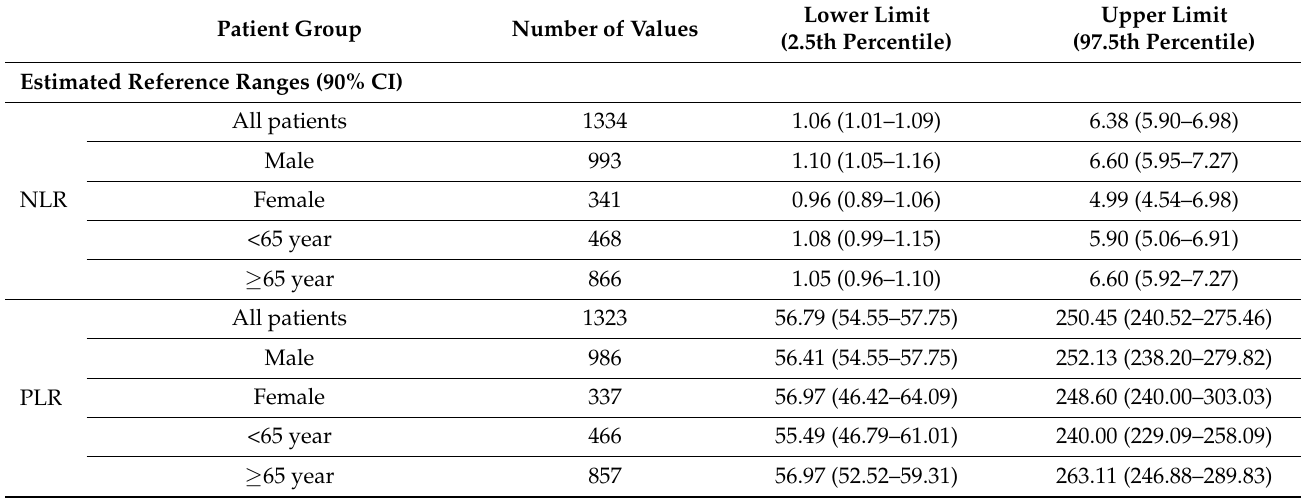
Table 2. NLR and PLR reference ranges in patients with IPF (pooled from all treatment groups in ASCEND and